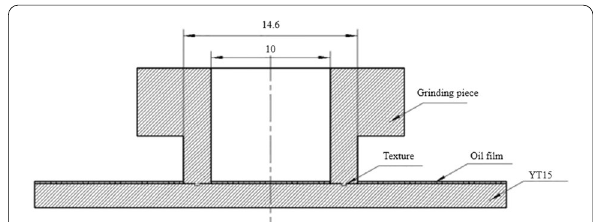
Figure 2 Schematic diagram of experiment